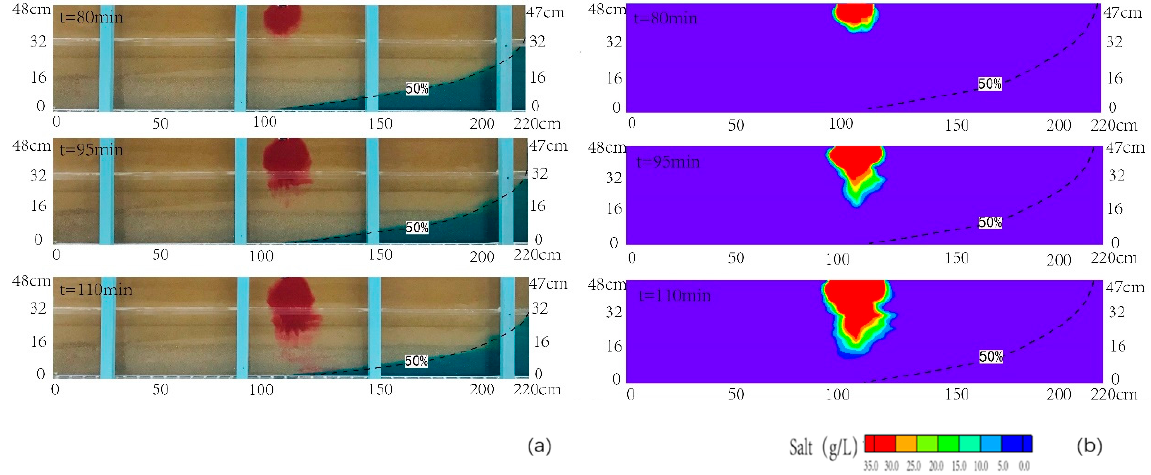
Figure 5. Observed ( a ) and simulated ( b ) contamination concentration distributions of the cross section for scenario 2. The black dashed line denoted the contour line with the concentration of 0.5 time of seawater concentration.